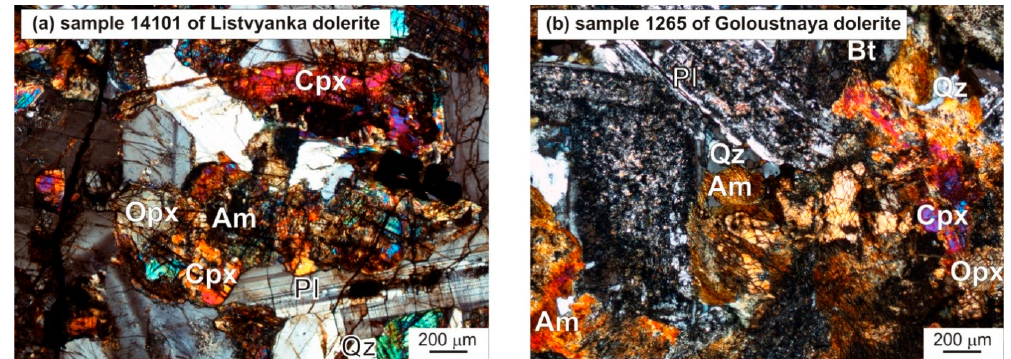
Figure 3. Photomicrographs of Listvyanka and Goloustnaya dolerites: ( a ) sample 14101 of Listvyanka dolerite and ( b ) sample 1265 of Goloustnaya dolerite. Mineral abbreviations: Amp, amphibole; Cpx, clinopyroxene; Opx, orthopyroxene; Pl, plagioclase; Bt, biotite; Qz, quartz.